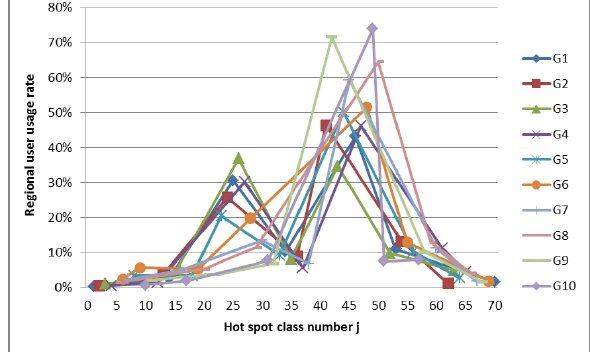
Figure 6. Usage rate of hot access areas